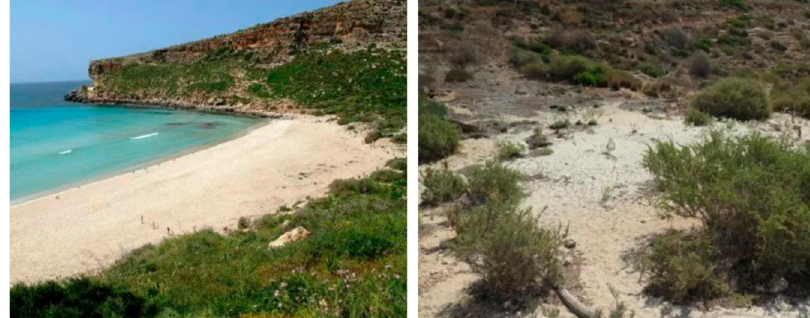
Figure 1. Chiliadenus lopadusanus in Conigli bay, Lampedusa island,